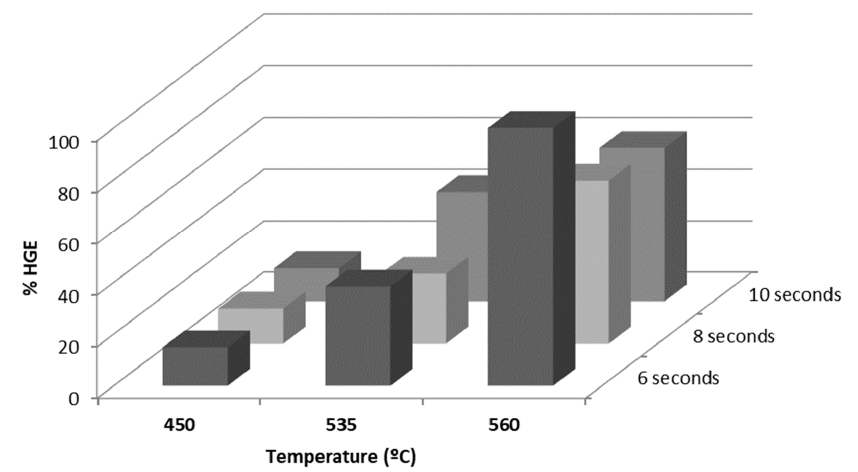
Figure 2. Effect of the reaction temperature on the SCWG of cellulose at 250 bar with an initial concentration of cellulose = 0.3 g cellulose/L and n = 0.4.